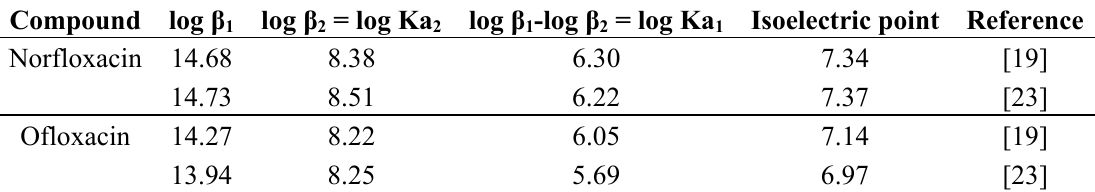
Table 3. Protonation constant values for norfloxacin and ofloxacin.